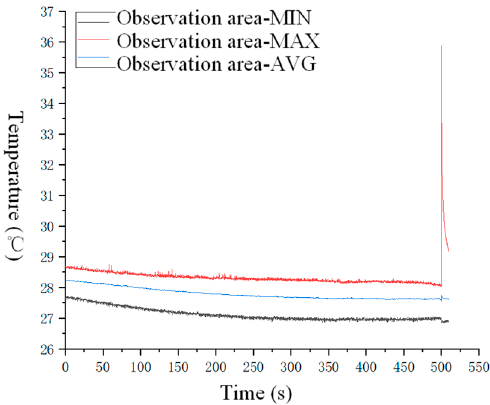
Figure 6. Temperature—time change curve of DL1-3 sample destruction process.